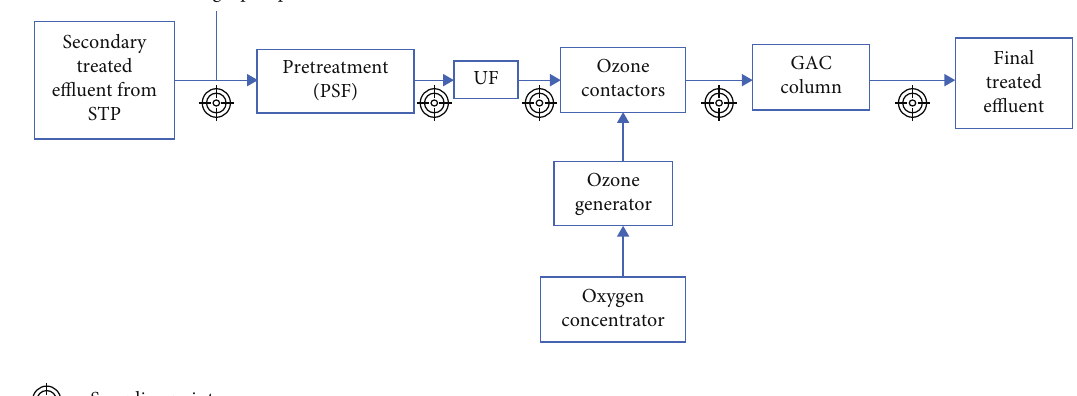
Figure 1: Treatment con fi guration